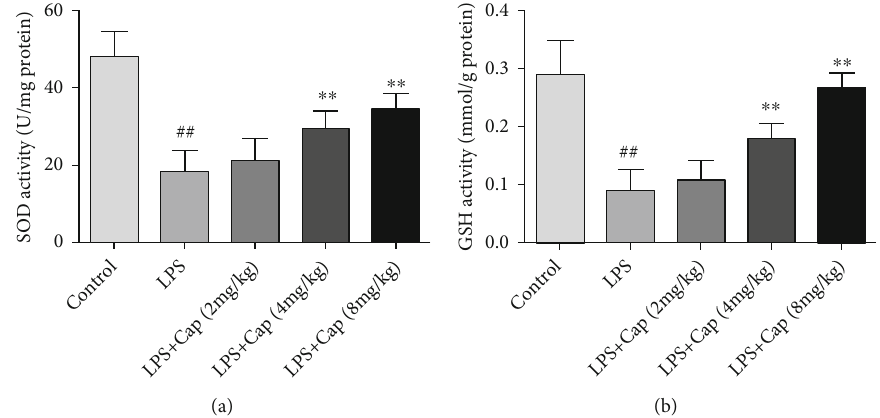
Figure 8: Cap improves the activities of antioxidant enzymes in neonatal rats with acute lung injury. The levels of SOD (a) and GSH (b) in BALF. Results are expressed as the mean ± standarddeviation ( n = 8 ). ## P < 0 : 01 compared to the control group; ∗∗ P < 0 : 01 compared to the LPS